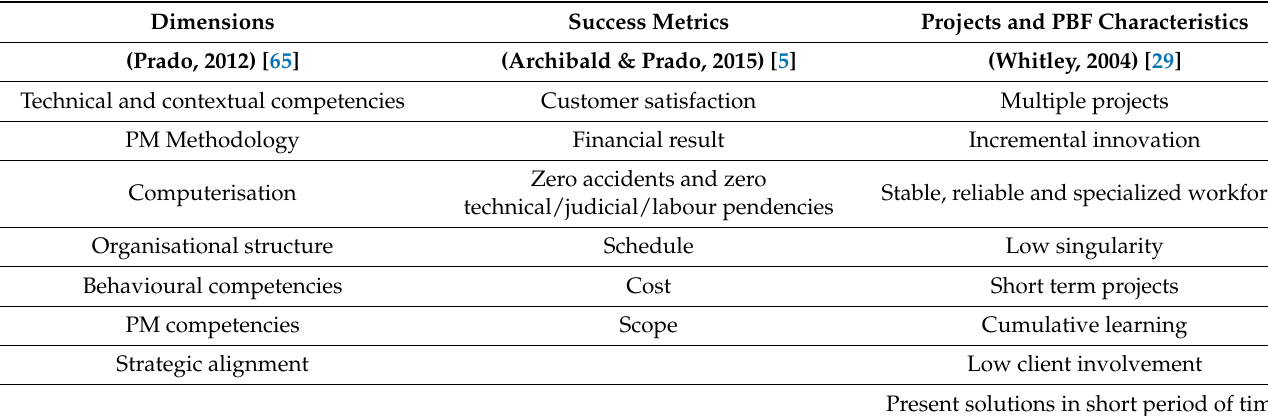
Table A3. Documental research conclusions